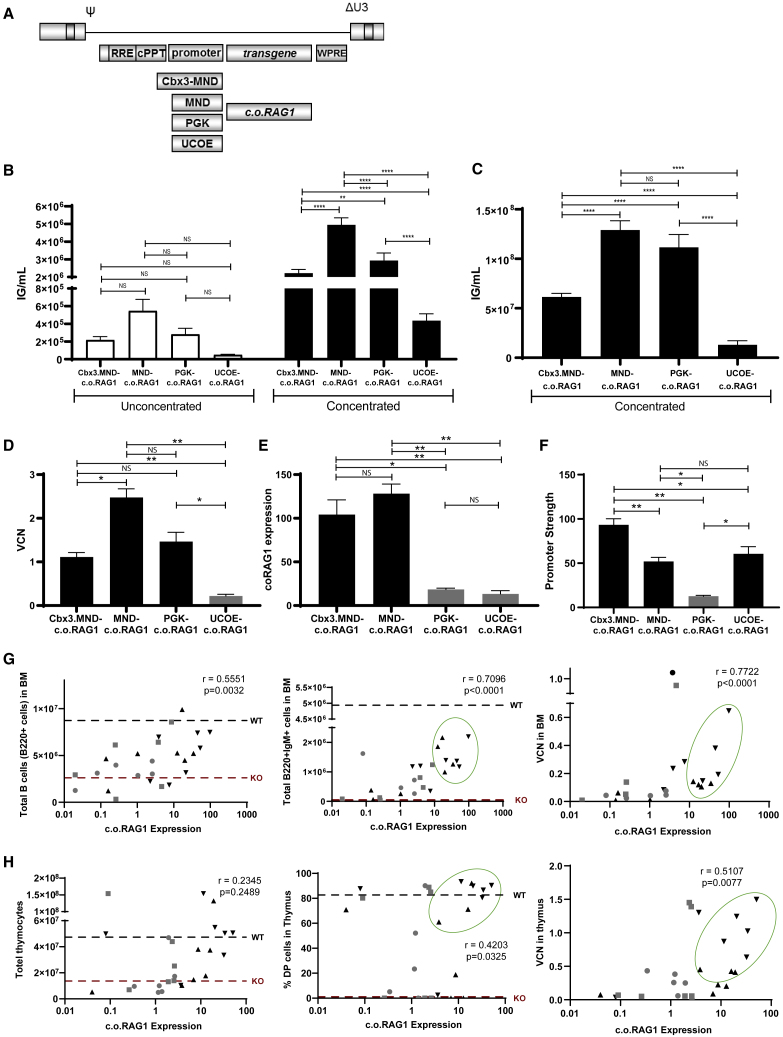
Selecting the Optimal SIN LV Plasmid: Virus Production And In Vitro Efficiency(A) Four different SIN LV plasmids in the CCL backbone carrying different promoters (Cbx3.MND, MND, PGK, and UCOE promoter) were tested to drive expression of a codon-optimized version of RAG1. (B) Production of lentivirus batches with the different constructs. The number of infective particles (infectious genomes/mL) from unconcentrated and concentrated small batches was determined. Three independent lentivirus small batches per plasmid were produced and analyzed (two-way ANOVA test; ∗p < 0.05, ∗∗p < 0.01). (C) Production of lentivirus batches on a large scale with the different constructs. The number of infectious genomes/mL after concentration of large lentiviruses batches was determined. (D) Transduction efficiency of the different SIN lentiviruses in murine lineage-negative cells. VCN was determined by WPRE determination on genomic DNA. Three independent lentivirus batches per plasmid were produced and analyzed (one-way ANOVA test; ∗p < 0.05, ∗∗p < 0.01. (E) Determination of transgene expression in the transduced cells by the different constructs. c.o.RAG1 expression relative to ABL1 was determined by qPCR. Three independent lentivirus batches per plasmid were produced and analyzed (one-way ANOVA test; ∗p < 0.05, ∗∗p < 0.01. (F) Determination of the promoter strength (c.o.RAG1 expression/VCN) of the different plasmids. Three independent lentivirus batches per plasmid were produced and analyzed (one-way ANOVA test; ∗p < 0.05, ∗∗p < 0.01). (G) Total number of B220+ cells (left panel) and total number of B220+IgM+ cells (middle panel) correlated with the expression of c.o.RAG1 in BM. The correlation between VCN and c.o.RAG1 expression in BM of immune reconstituted mice is shown (right panel) (▲, Cbx3.MND; ▼, MND; ▪, PGK; ●, UCOE promoters; gray indicates low-expressing plasmids; black indicates high0expressing plasmids; green circles indicate mice with acceptable immune B and T cell reconstitution). Data shown represent two independent in vivo experiments with in total six or seven mice per group. Each dot represents one mouse. Nonparametric Spearman r correlation, two-tailed; ∗∗p < 0.01, ∗∗∗p < 0.001, ∗∗∗∗p < 0.0001. (H) Correlation between total thymocytes (left panel) and DP cells (middle panel) with c.o.RAG1 expression in the thymus. Correlation between VCN and c.o.RAG1 expression in the thymus of immune reconstituted mice (right panel) (▲, Cbx3.MND; ▼, MND; ▪, PGK; ●, UCOE promoters; gray indicates low-expressing plasmids; black indicates high-expressing plasmids; green circles indicate mice with acceptable immune B and T cell reconstitution). Data shown represent two independent in vivo experiments with in total six or seven mice per group. Each dot represents one mouse. Nonparametric Spearman r correlation, two-tailed; ∗∗p < 0.01, ∗∗∗p < 0.001, ∗∗∗∗p < 0.0001.